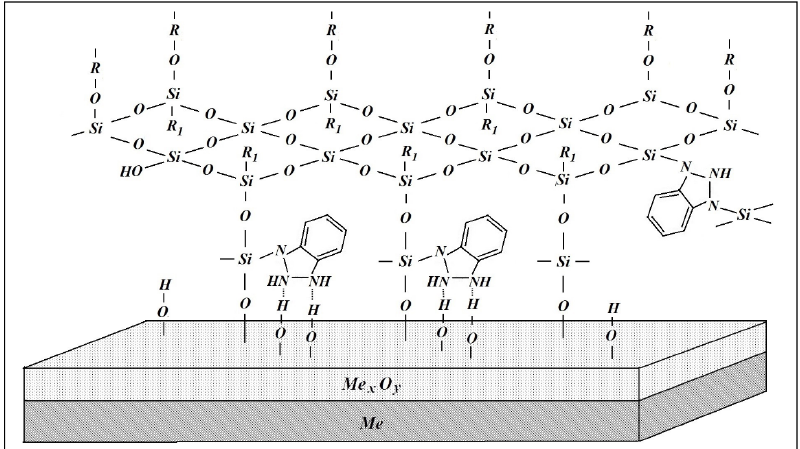
Figure 6. Scheme of the structure of the interface metal/siloxane–azole layer. As expected, the mixture of VS and BTA inhibited the local corrosion of copper. So, after one year of exposure, the average diameter of the pittings on the copper modified by a solution of a mixture of VS and BTA decreased by almost three times, compared with the unmodified copper, and almost two times, compared with the modification with a solution of only VS.